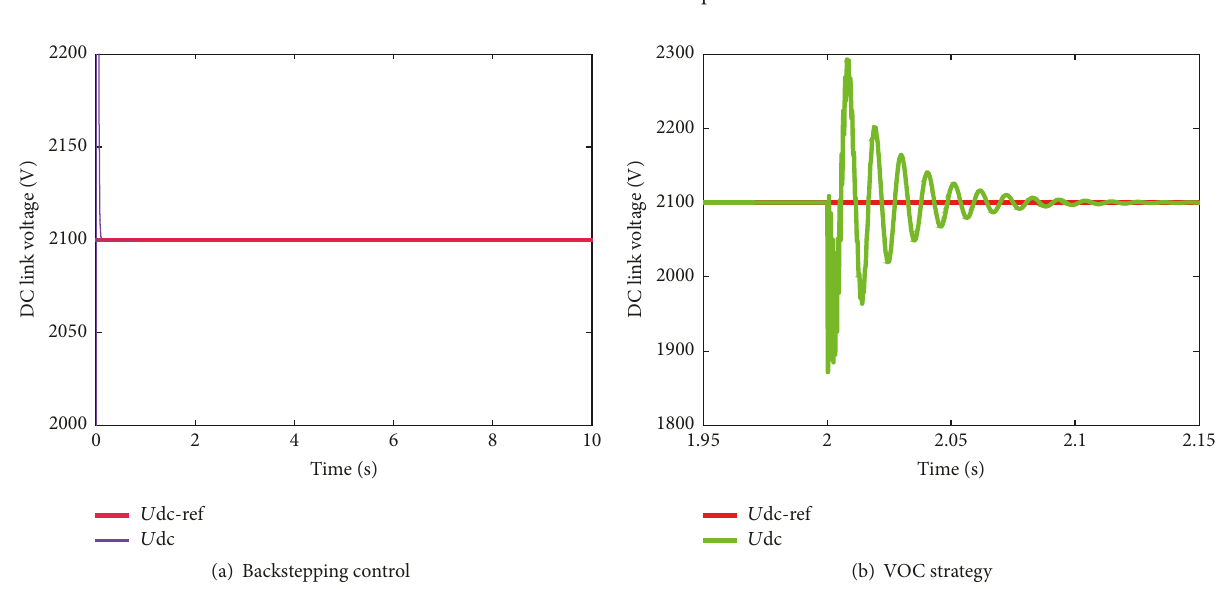
Figure 13: Coefficient of power.